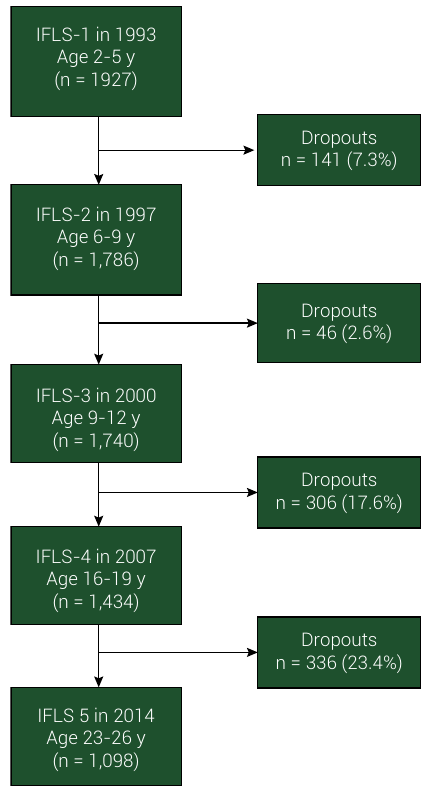
Figure 1. IFLS flowchart in this